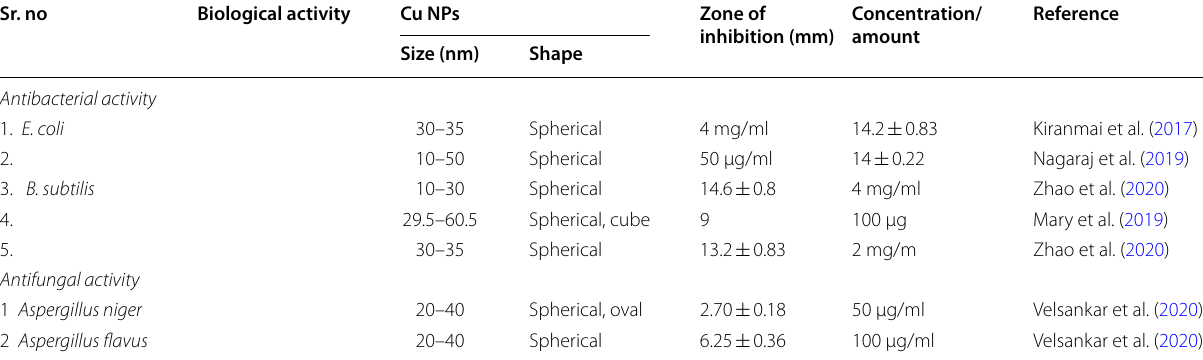
Table 3 Biological activity of green synthesized copper nanoparticles